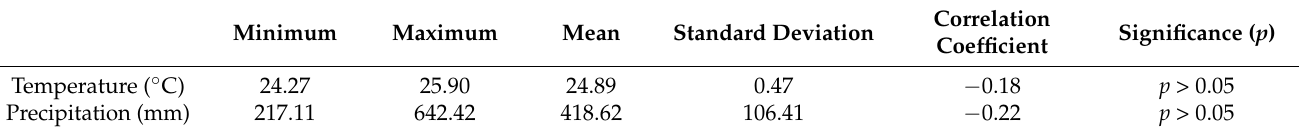
Figure 5. Spatio-temporal trend analysis of average groundwater trends with temperature ( A ) and precipitation ( B ) in 2000–2015. Table 4. Statistics of climatic factors and their correlation with DWT.